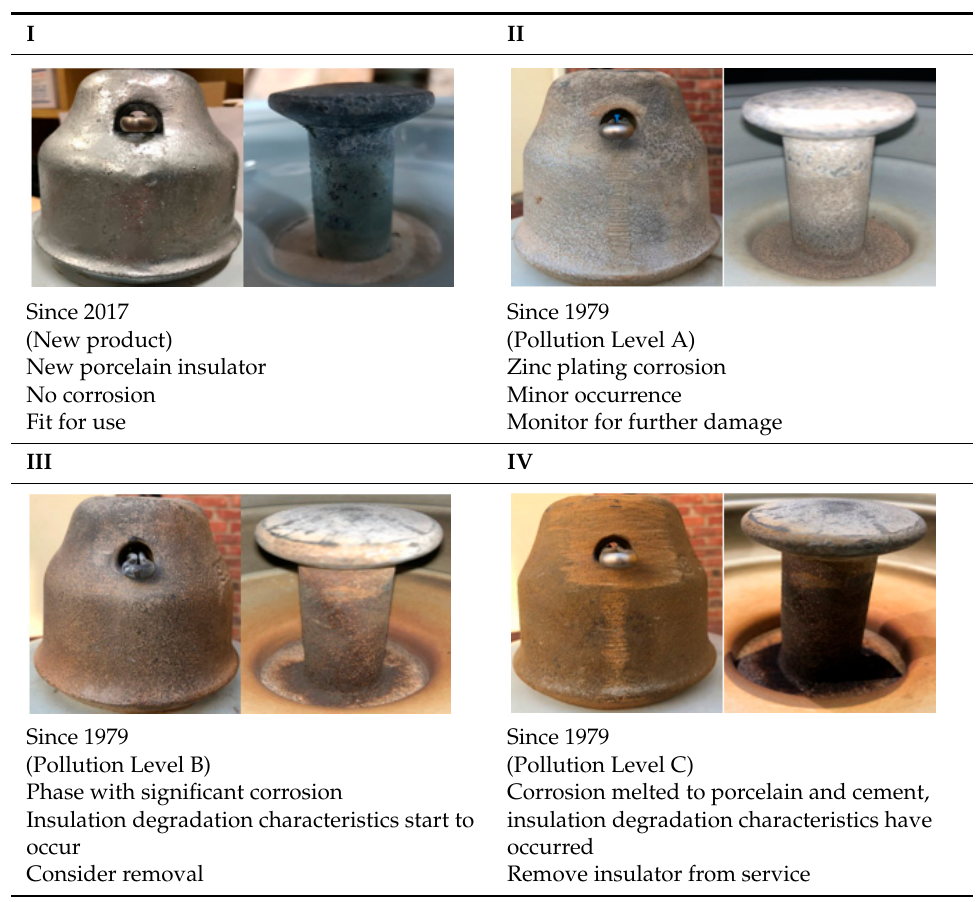
Table 1. Step-by-step countermeasures of corrosion according to the level of contamination of the porcelain insulator.